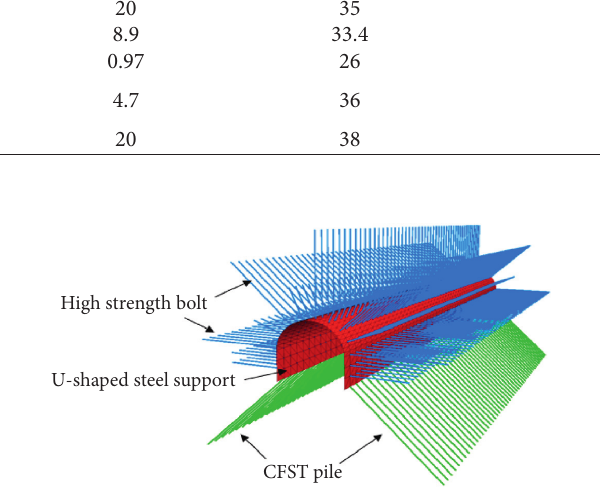
Figure 11: Structural element model.